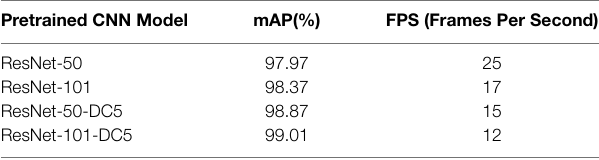
TABLE 4 | Detection performance of different pretrained CNN models.